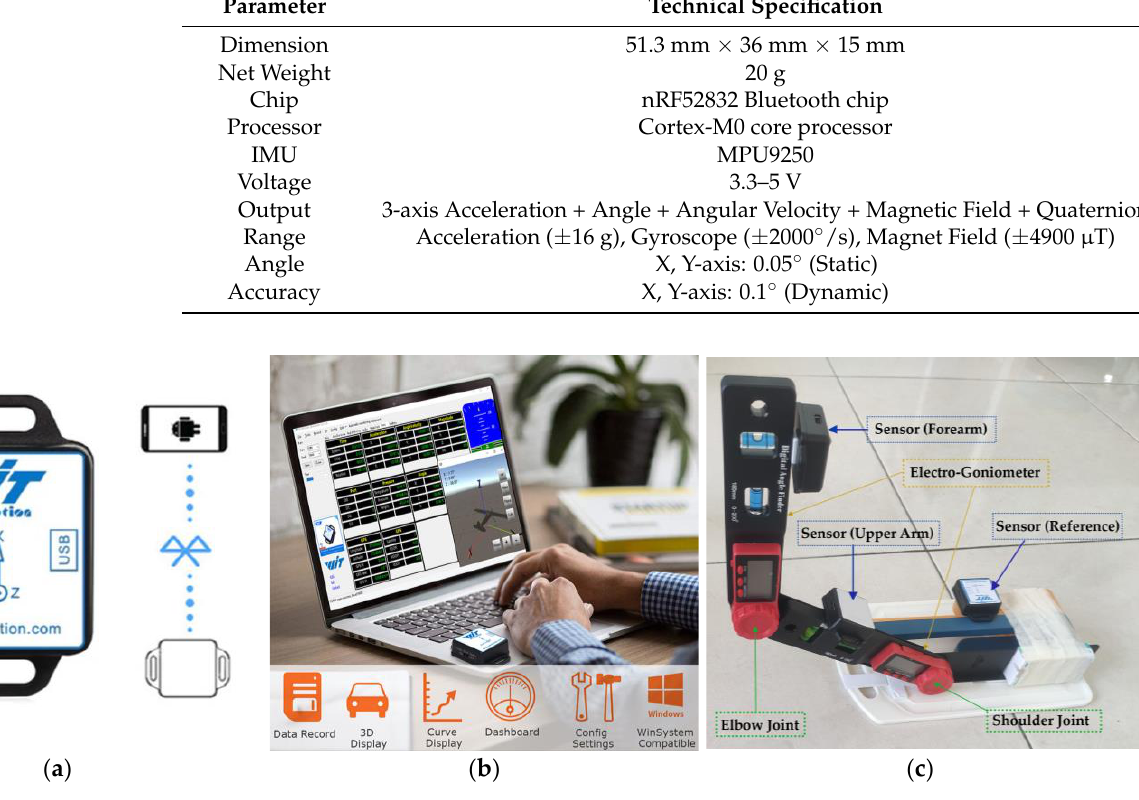
Figure 1. ( a , b ) The hardware of the motion capture system. Source: https://www.wit-motion.com/. ( c ) Three-dimensional rigid body structure. ( c ) Three-dimensional rigid body